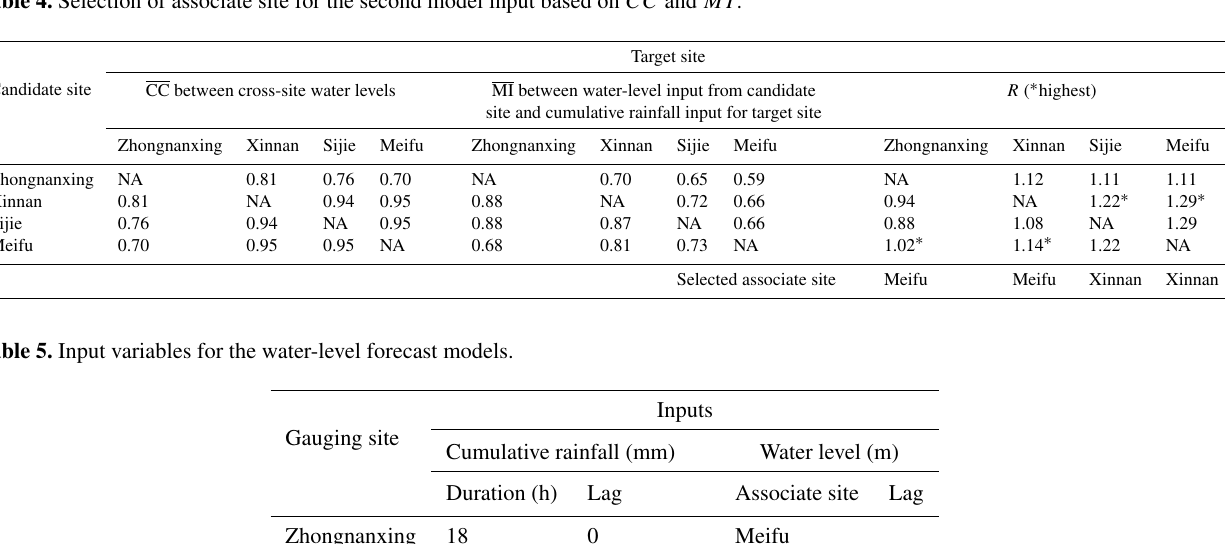
Table 4. Selection of associate site for the second model input based on CC and MI .